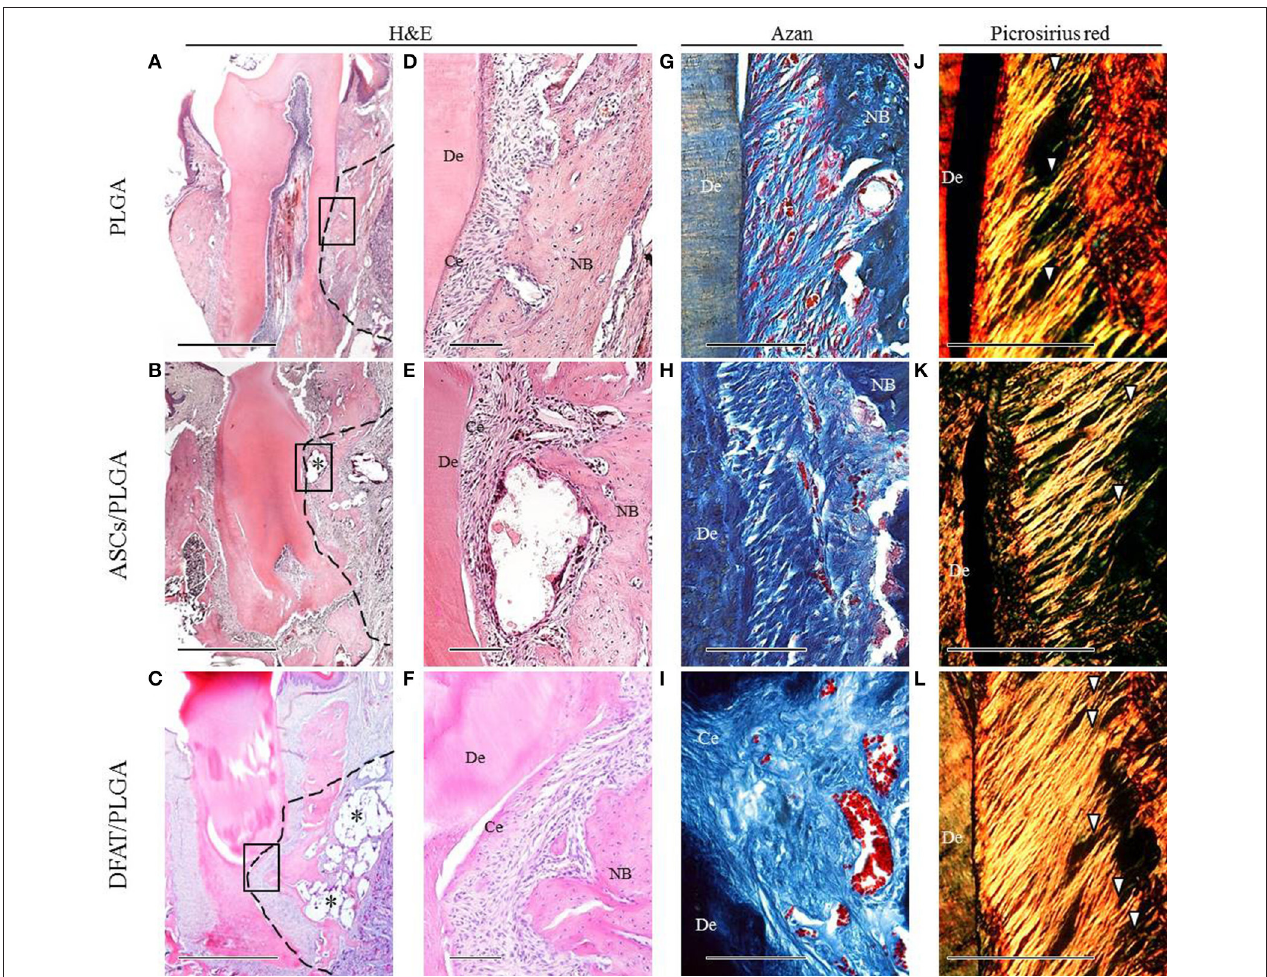
FIGURE 8 | Representative histological observation of frontal plane section in distal root of first molar. (A–C) Overview of H&E staining showing significant bone formation in DFAT/PLGA and ASCs/PLGA groups. Asterisks indicate scaffold remnants. The dotted line indicates defect sites. Scale bar = 1000 µ m. (D–F) Higher magnification of the framed area in (A–C) , respectively. Newly formed abundant cementum was observed in the DFAT/PLGA group. Scale bar = 100 µ m. (G–I) Azan staining at higher magnification showed collagen bundles in the PLGA-alone group. Collagen bundles of more than 100 µ m width were observed in the ASCs/PLGA and DFAT/PLGA groups. Scale bar = 100 µ m. (J–L) Enlarged images of the area equivalent to (G–I) , stained with Picrosirius-red staining to show periodontal ligament fibers. Arrowheads indicate newly formed collagen fibers. Scale bar = 100 µ m. NB, newly formed bone; Ce, newly formed cementum; De, root